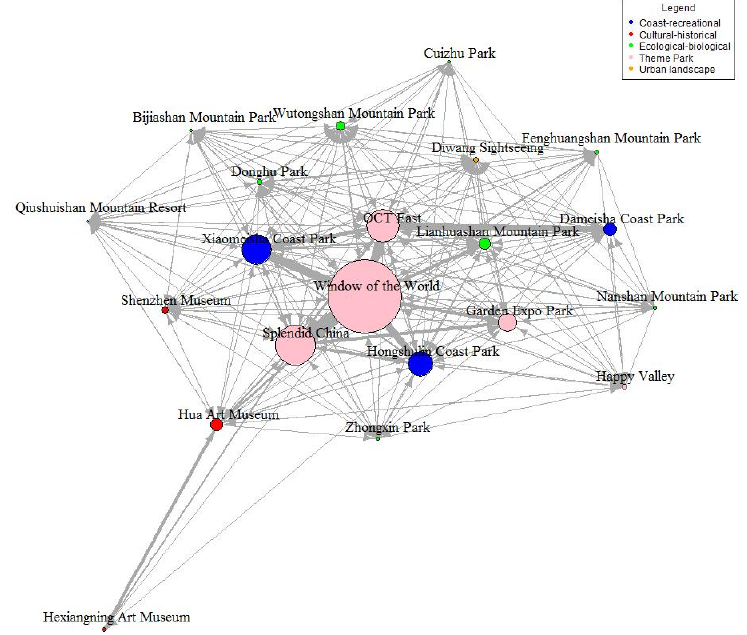
Figure 7. Space diagram of scenic spot combinations of tourists from outside Shenzhen who visited many attractions in 15 days.